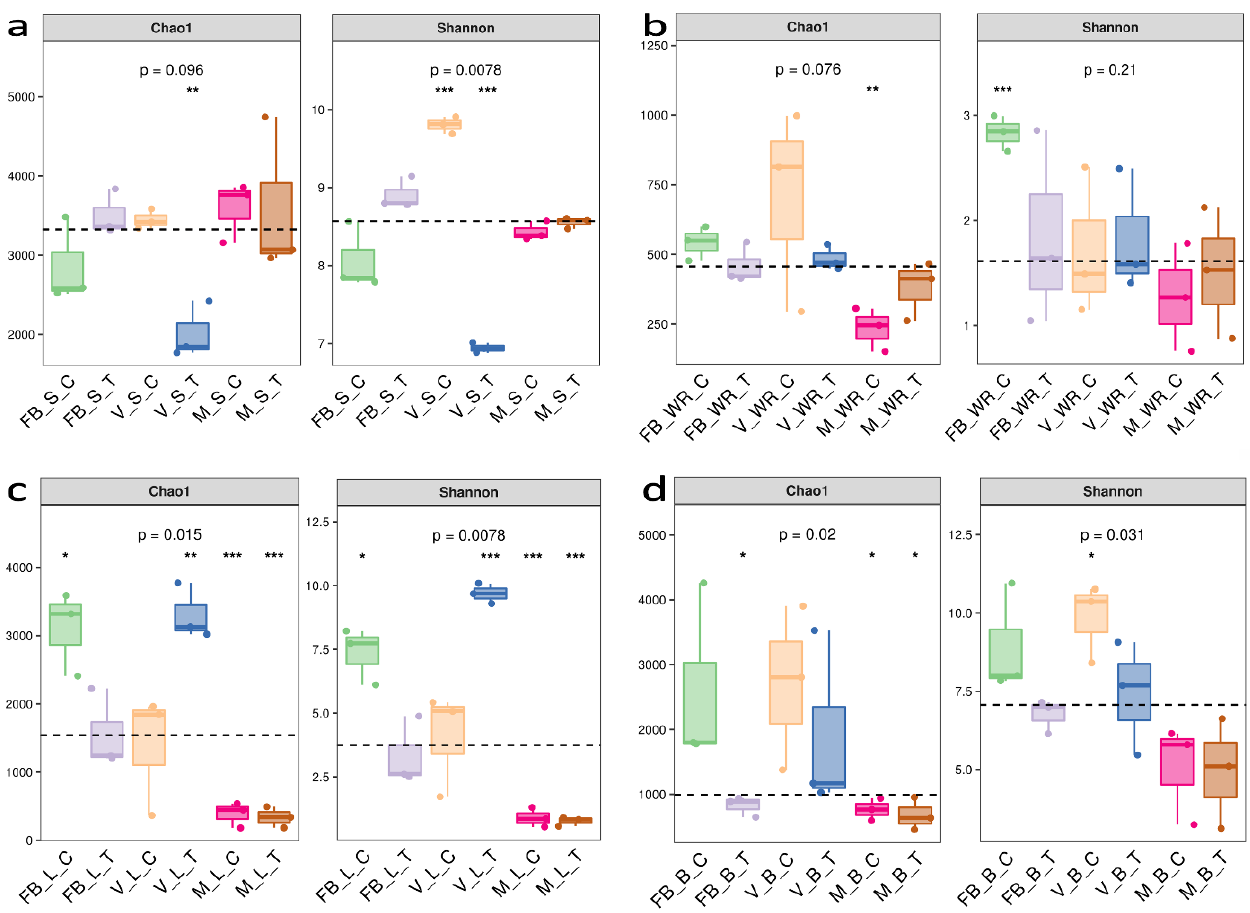
Figure 2. Alpha diversity indices Chao1 and Shannon. ( a ) Rhizosphere soil, ( b ) white roots, ( c ) leaves and ( d ) berries at three growth stages with comparison to treatment and control.